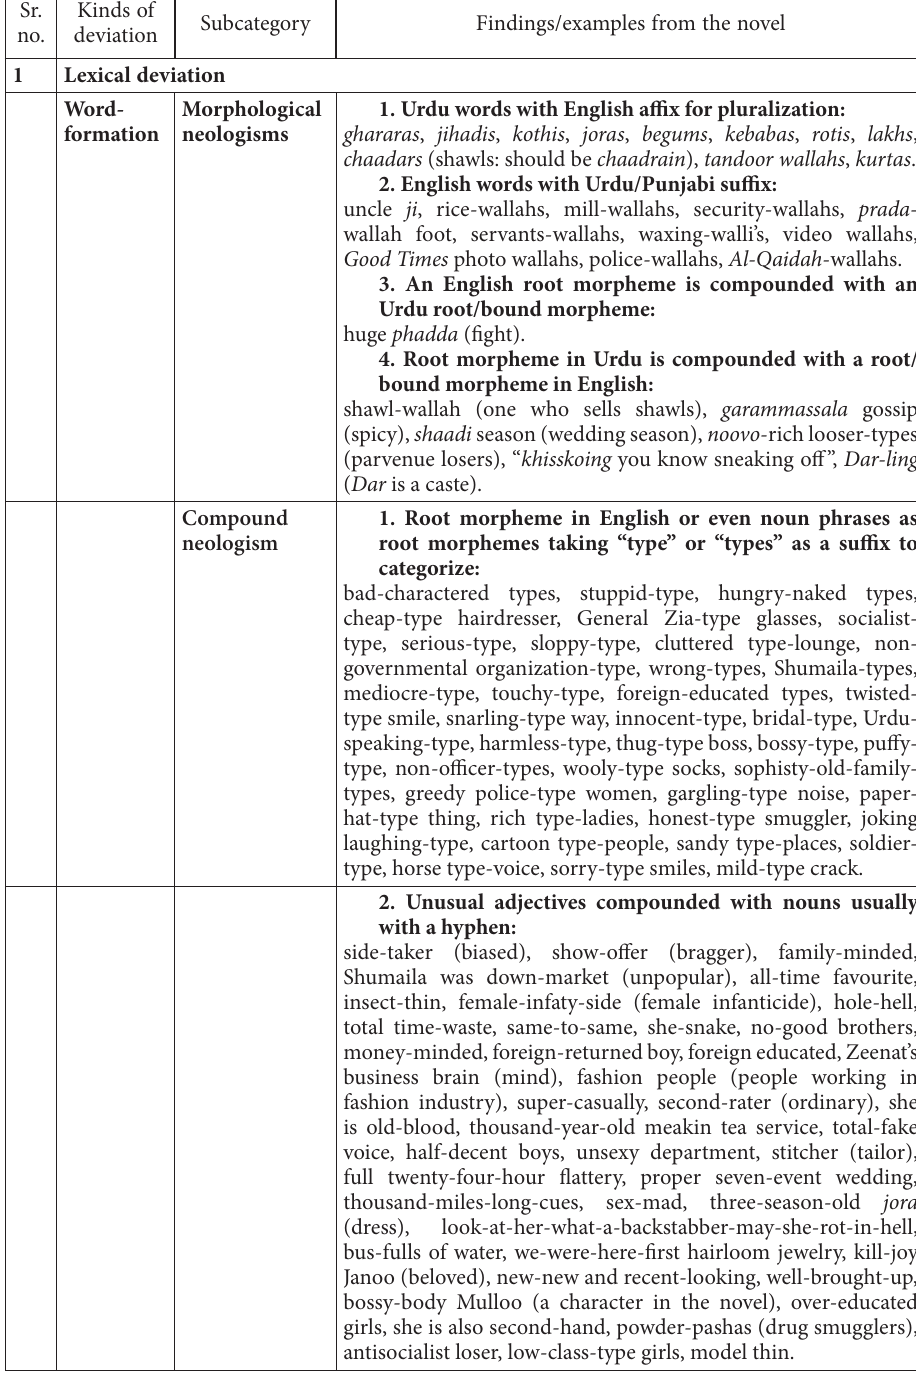
Table 1. Types and examples of lexical deviation in Moni Mohsin’s Duty Free (a novel) (source: created by author) Sr.